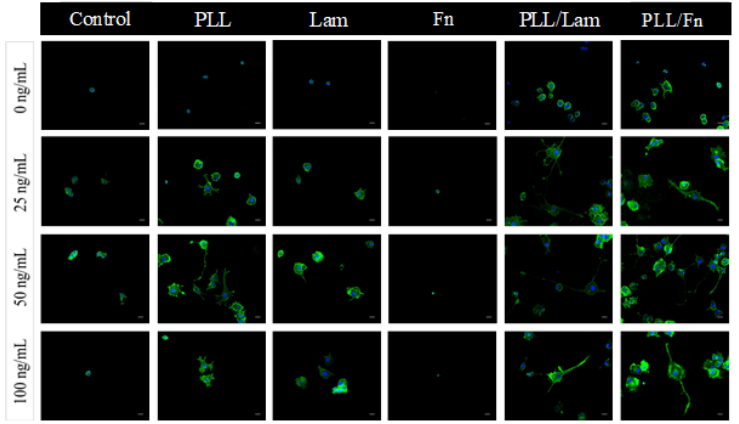
Figure 2. Comparative differentiation of PC12 cells on substrata with single- and two-component coatings in the presence of NGF solution. The NGF concentrations used were 0, 25, 50, and 100 ng/mL. Cells were grown over a period of five days; fixed in 4% PFA for 15 min and stained with WGA-488 (membrane, green), DAPI (nuclei, blue). Significant neurite outgrowth was observed for cells grown on substrata with double coatings containing poly-L-lysine/laminin and poly-L-lysine/fibronectin. Substrata containing single coatings of poly-L-lysine and laminin exhibited poor cell differentiation. PC12 cells incubated on Fn- or non-coated surfaces exhibited little to no attachment propensity in both the presence and absence of NGF. These results are consistent with previously reported